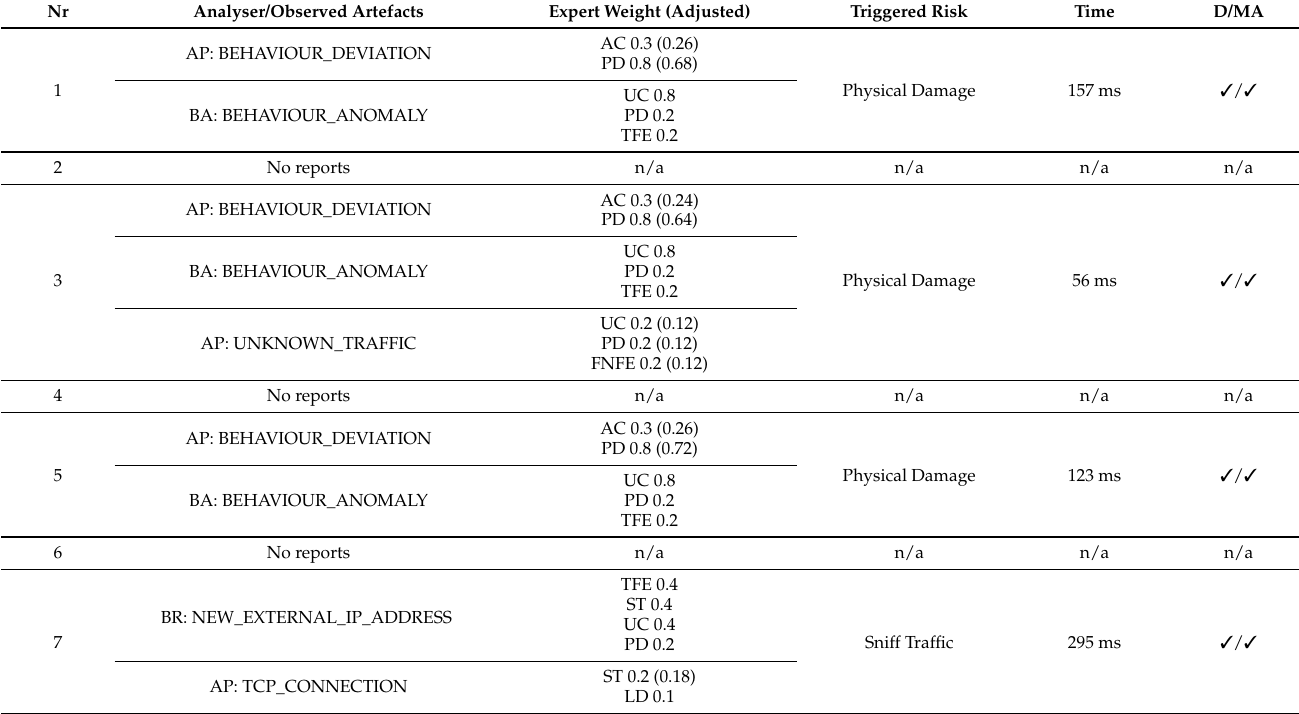
Table 10. Detection of attacks, receptors, and